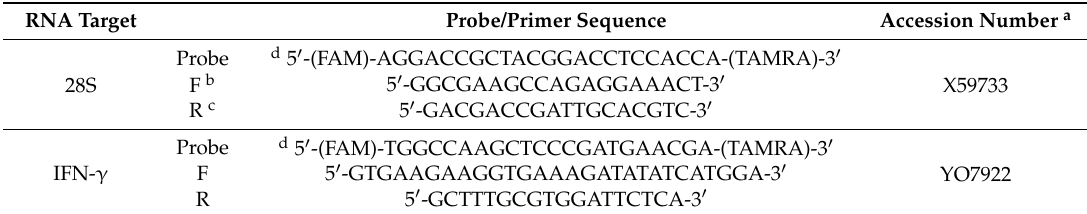
Table 7. Real-time quantitative RT-PCR probes and primers for 28S and IFN- γ . RNA